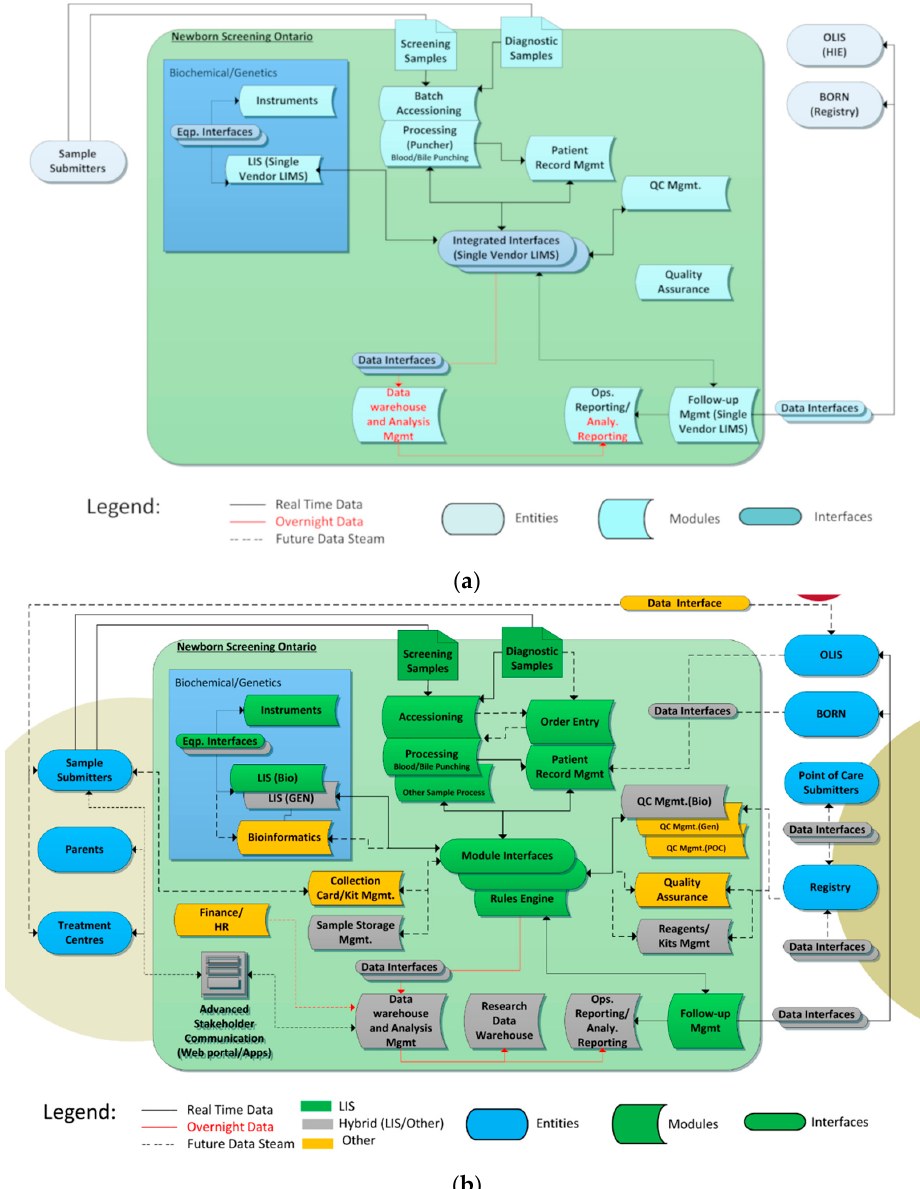
Figure 3. ( a ) NSO Enterprise Architecture—Initial State; ( b ) NSO (Newborn Screening Ontario) Enterprise Architecture—Desired Final State.